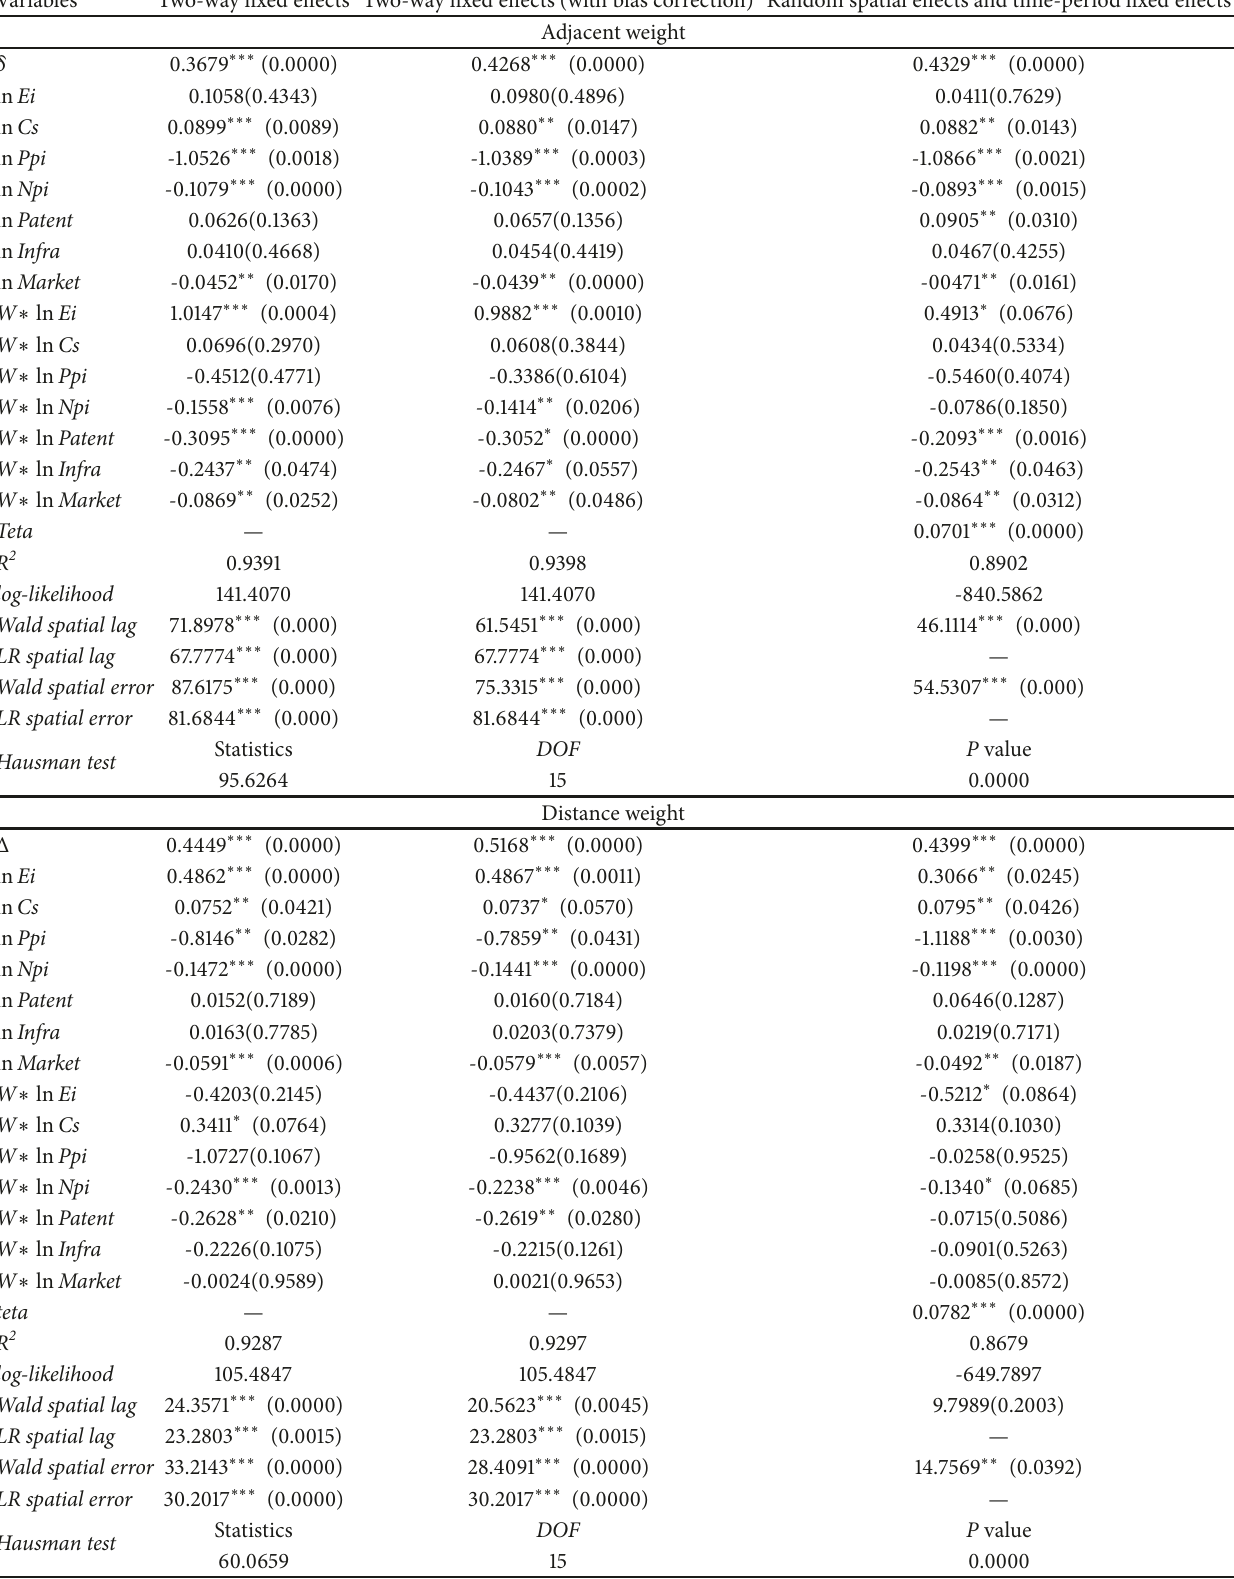
Table 5: Estimation results of spatial Durbin